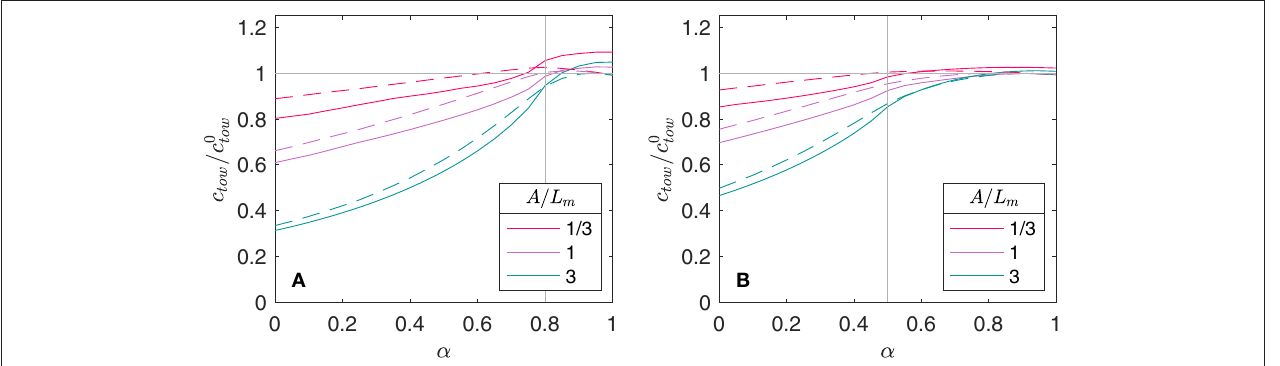
FIGURE 9 | Modeled captured particles as a function of net lag parameter α for various A / L m . The total number of particles captured in a net tow per volume c tow is normalized by c 0 tow which represents the predicted amount without waves. The solid lines denote the results from numerical simulations, and the dashed line denote the results using the analytically modeled concentration as described by Equation (13). The vertical gray line denotes the α value when the net drops below the free surface for part of the wave cycle. In these data, ǫ 0.1 in both cases, and δ/ A 0.2 (A) and δ/ A 0.5 (B) = = =